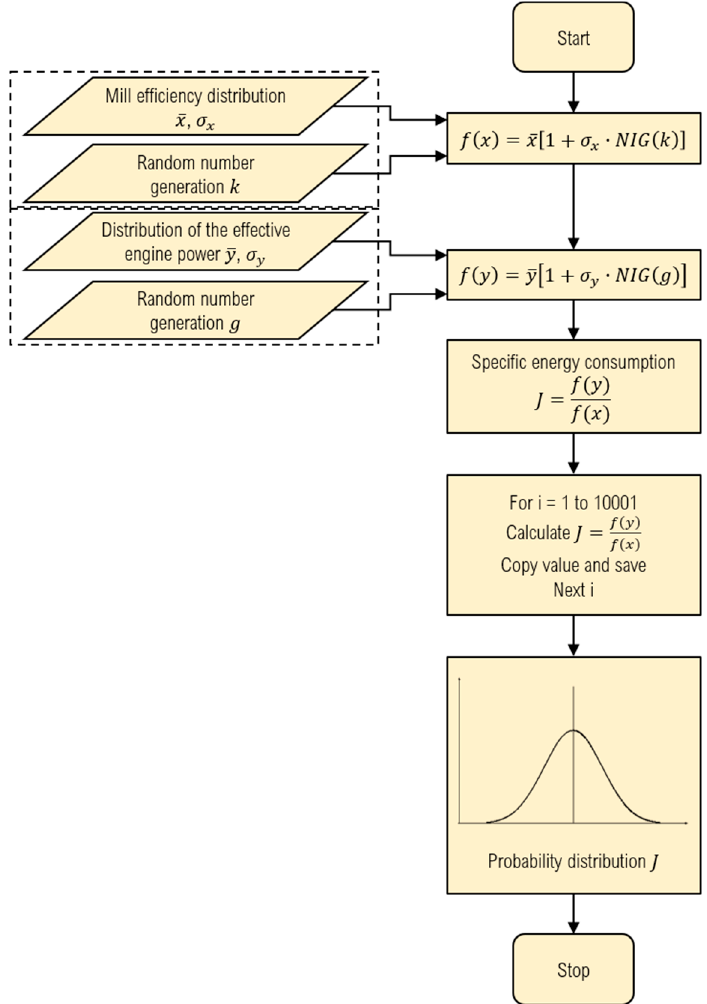
Figure 12. Algorithm of the Monte Carlo simulation.